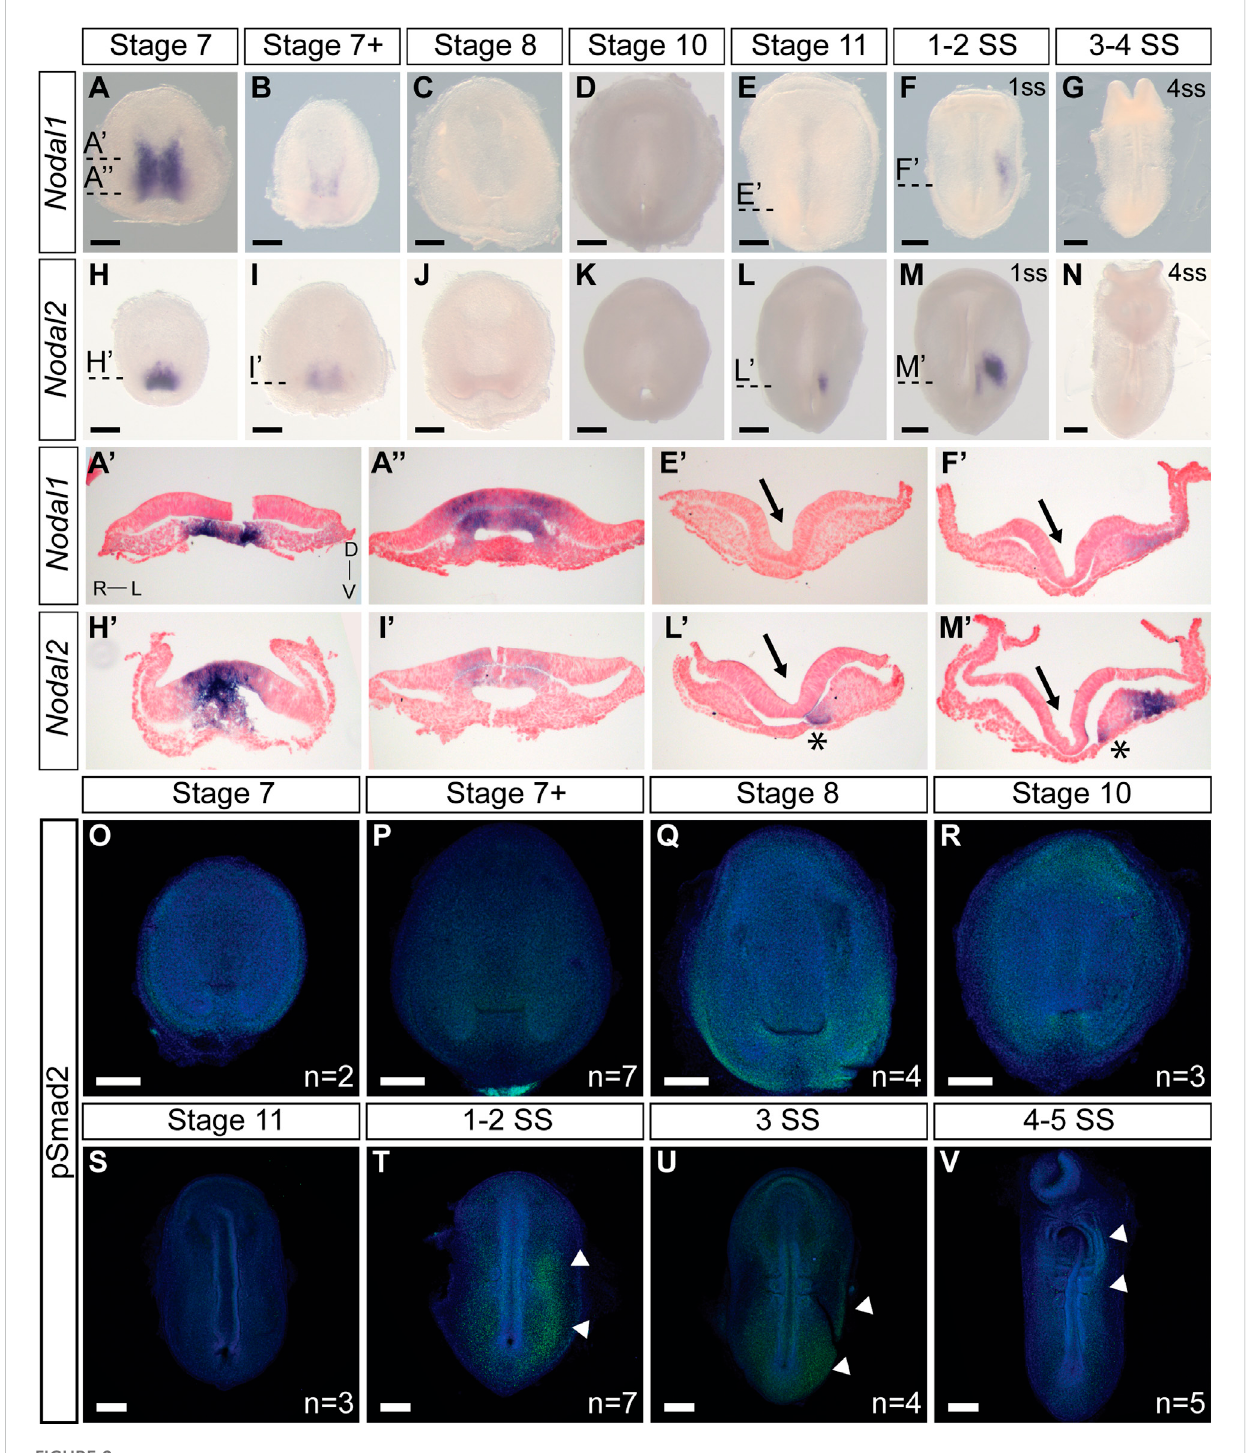
FIGURE 2 Expression and activity of Nodal1 and Nodal2 in veiled chameleon embryos. All embryos are presented in ventral view, unless otherwise noted. Dorsal view available in Supplementary Figures S2, S3. (A – G) Whole mount RNA in situ hybridization for Nodal1 expression. ( H – N ) Whole mount RNA in situ hybridization for Nodal2 expression. (A 9 , A 99 , E 9 , F 9 , H 9 , I 9 , L 9 , M 9 ) Transverse sections of embryos from (A – N) , as indicated with dashed lines. Sections were counterstained with nuclear fast red for better visualization. Section orientation is as indicated in (A 9 ) . Asterisk denotes Nodal2 expression in presomitic mesoderm. Arrows point to the medial hinge point of the neural tube. ( O – V) The presence of active Nodal signaling was evaluatedthroughantibodystainingforpSmad2(green),withnuclearDapistaininginblue.WhitearrowheadsdenoteareasofpSmad2enrichmentvisible inthis view.Normalized pSmad2 staining of embryos and intensity analysis betweenleftand rightsides isavailable in Supplementay Figure S3. nindicates the number of embryos examined for a given stage. All scale bars are 200 μ